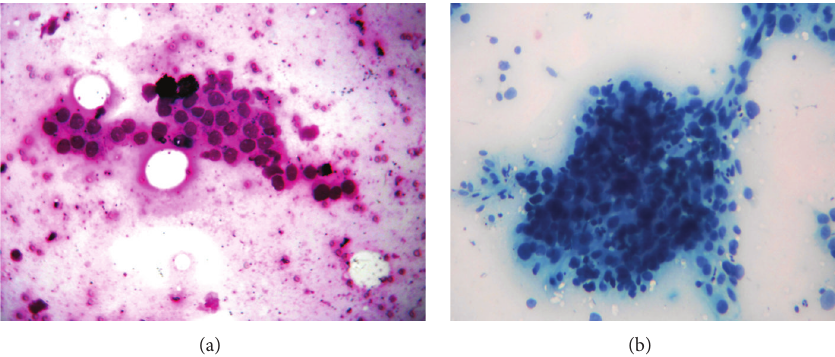
Figure 2: (a) Microphotograph of FNAC of osteolytic lesion of left humerus showing metastatic squamous cell carcinoma (MGG stain, 10x). (b) Microphotograph of FNAC of left lung nodule showing squamous cell carcinoma (MGG stain, 10x).